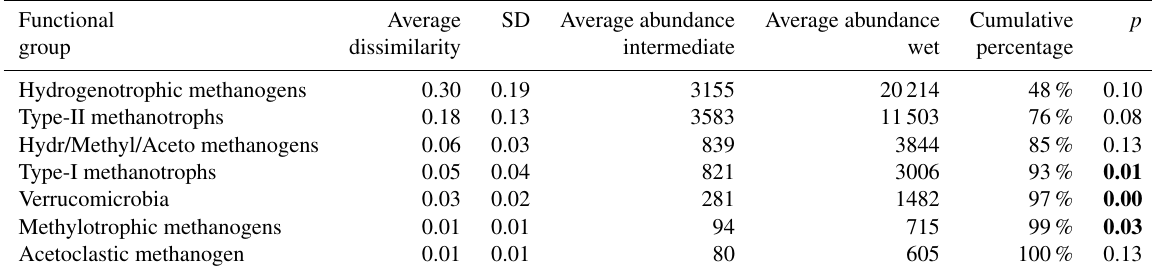
Figure 9. Temporal variation in δ 13 C-CH 4 against F CH , in each chamber location in 2019 and 2020. The marker labels indicate the day of 4 year. Only very few data points from chamber 3 passed the quality criteria in 2020, resulting in only one 10d average. Table 3. Results of SIMPER (similarity of percentage, a function that performs pairwise comparisons of groups of sampling units and finds the average contributions of each species to the average overall Bray–Curtis dissimilarity) analysis between intermediate ( n = 7) and wet ( n = 4) plots. Functional groups are ranked according to their average contribution to dissimilarity between plots. Standard deviation (SD), average abundances, percentage of cumulative contribution, and the permutation p value (probability of obtaining a larger or equal average contribution in random permutation of the group factor) are also